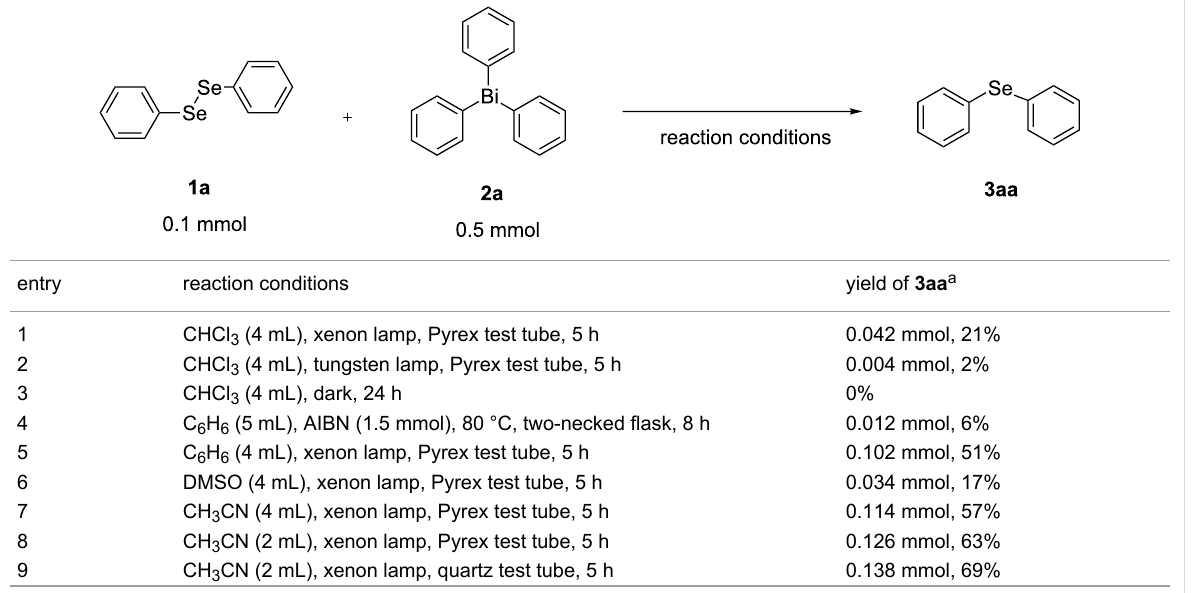
Table 1: Reaction of diphenyl diselenide with triphenylbismuthine under different conditions.